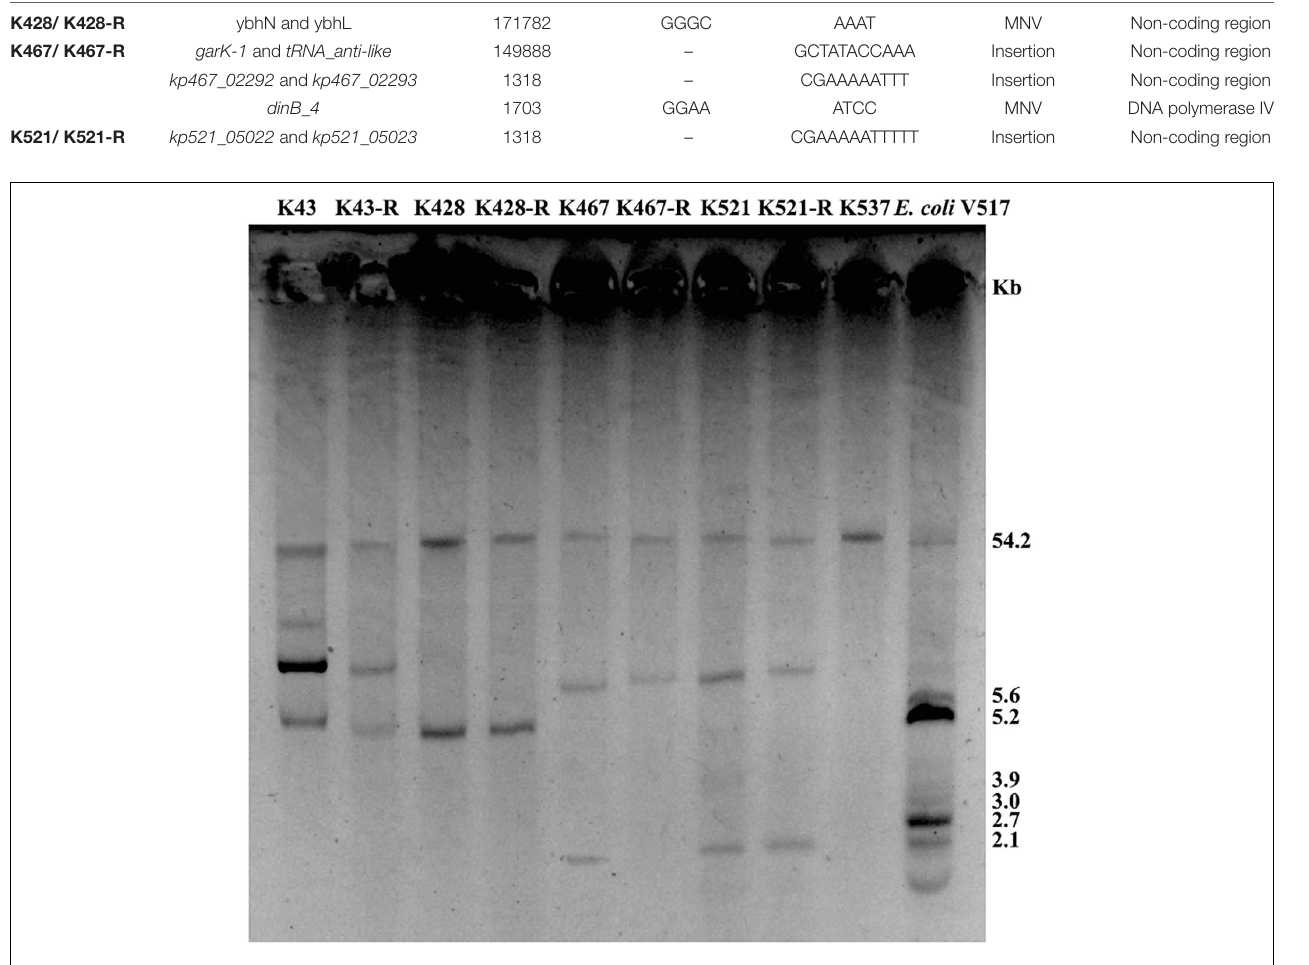
populations to aminoglycosides (Barbosa et al., 2017).